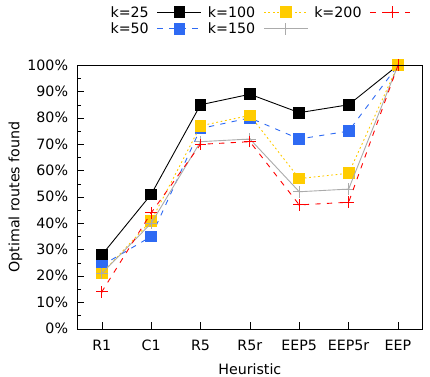
Figure 6: Optimal routes found withinMunich , varying k .